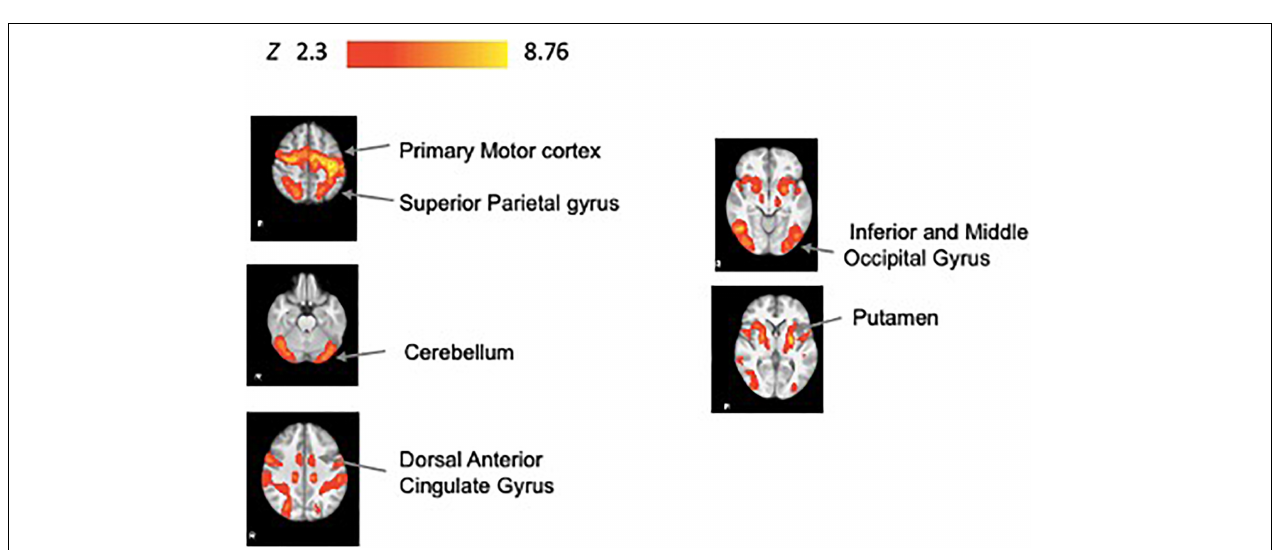
FIGURE 2 | Task performance improves with practice. Group average showing performance curve for (A) time on target and (B) temporal accuracy (time lag). IR, immediate retention; DR, delayed retention. Error bars = ± 1 standard error ( N = 40).